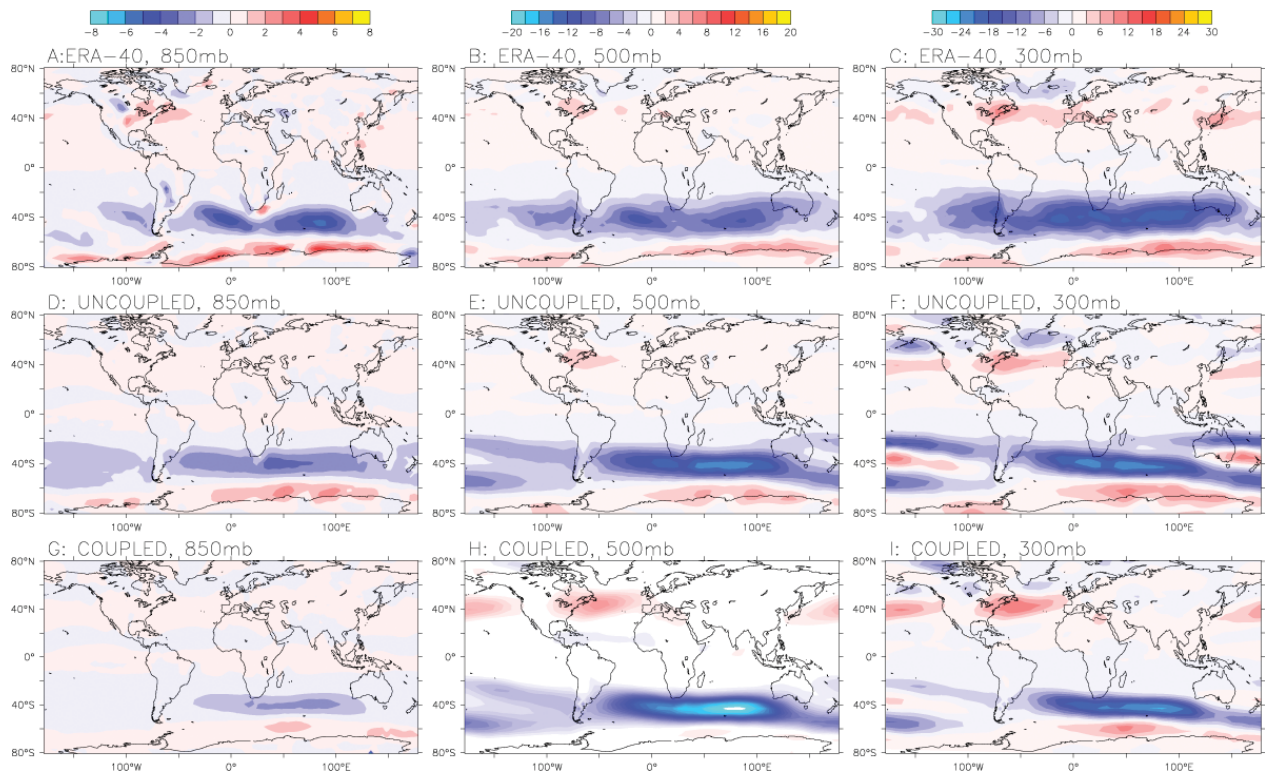
Fig. 6. Band-pass filtered ERA-40 data at (a) 850mb, (b) 500mb and (c) 300mb of h u 0 v 0 i (in m 2 s − 2 ) for June-July-August. (d–f) show results of “uncoupled” and (g–i) “coupled” experiments using Aeolus (Eq. 2) at same pressure